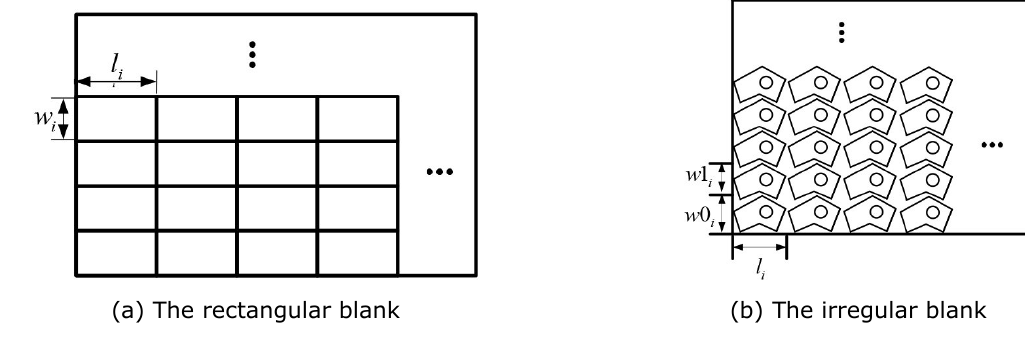
Figure 7. The blanks number of the homogenous strip x 